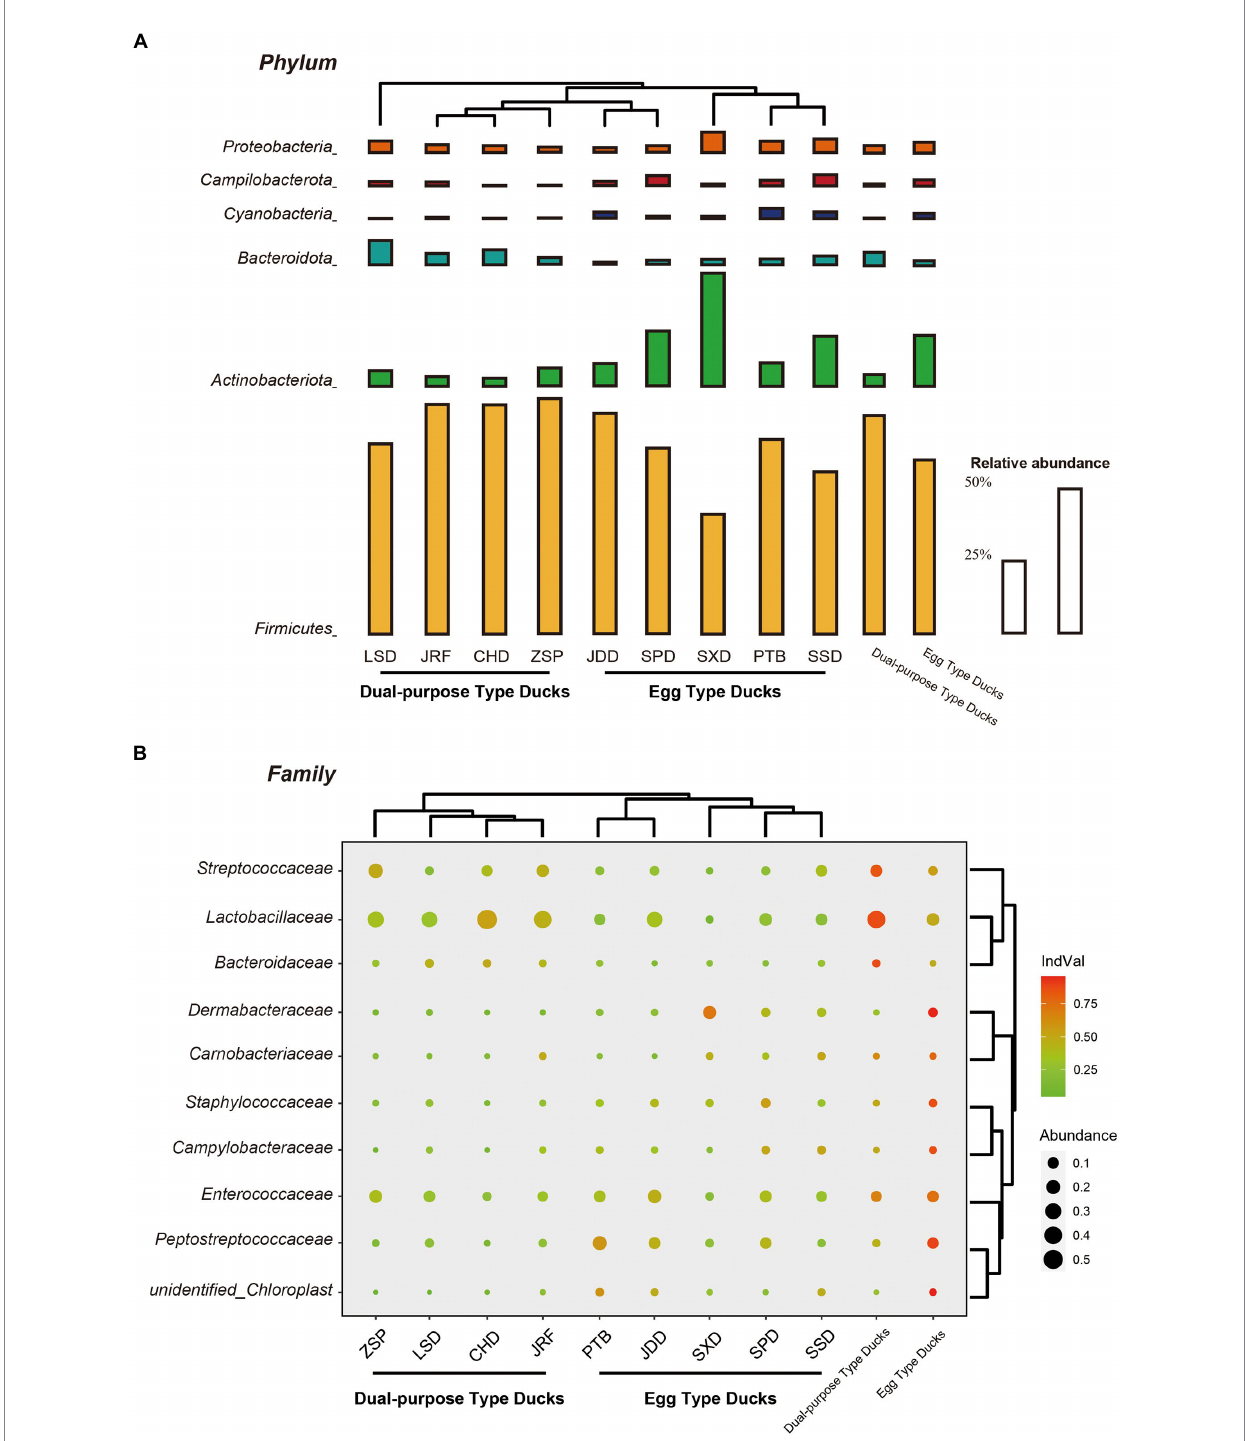
FIGURE 4 Microbial compositions of Chinese ducks. The average relative abundances of the most prevalent bacterial (A) phyla (bar length) and (B) families (circle size) in each sample type (indicated as above bubble plot) plotted for samples from the two groups and nine breeds. Cluster tree of domestic ducks showed similarities in the structure and composition of the fecal microbiota. The indicator value index (shading of circle color) represents the strength of association between a taxon and a given sample type, with larger values indicating greater